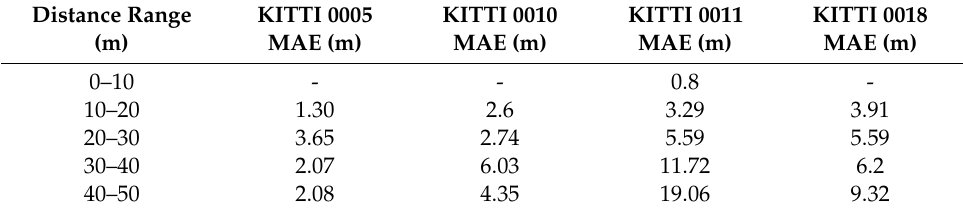
Table 3. Mean Absolute Error (MAE) analysis on trips from KITTI dataset.